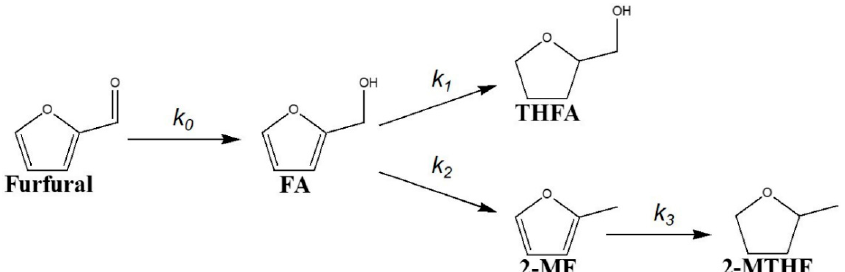
Figure 11. Scheme of furfural hydrogenation over calcined and reduced Ni x MoC–SiO 2 (400/600) catalysts at T = 150 °C, P = 6.0 MPa, m cat = 1.000 g, and furfural/isopropanol molar ratio equal to 0.033.